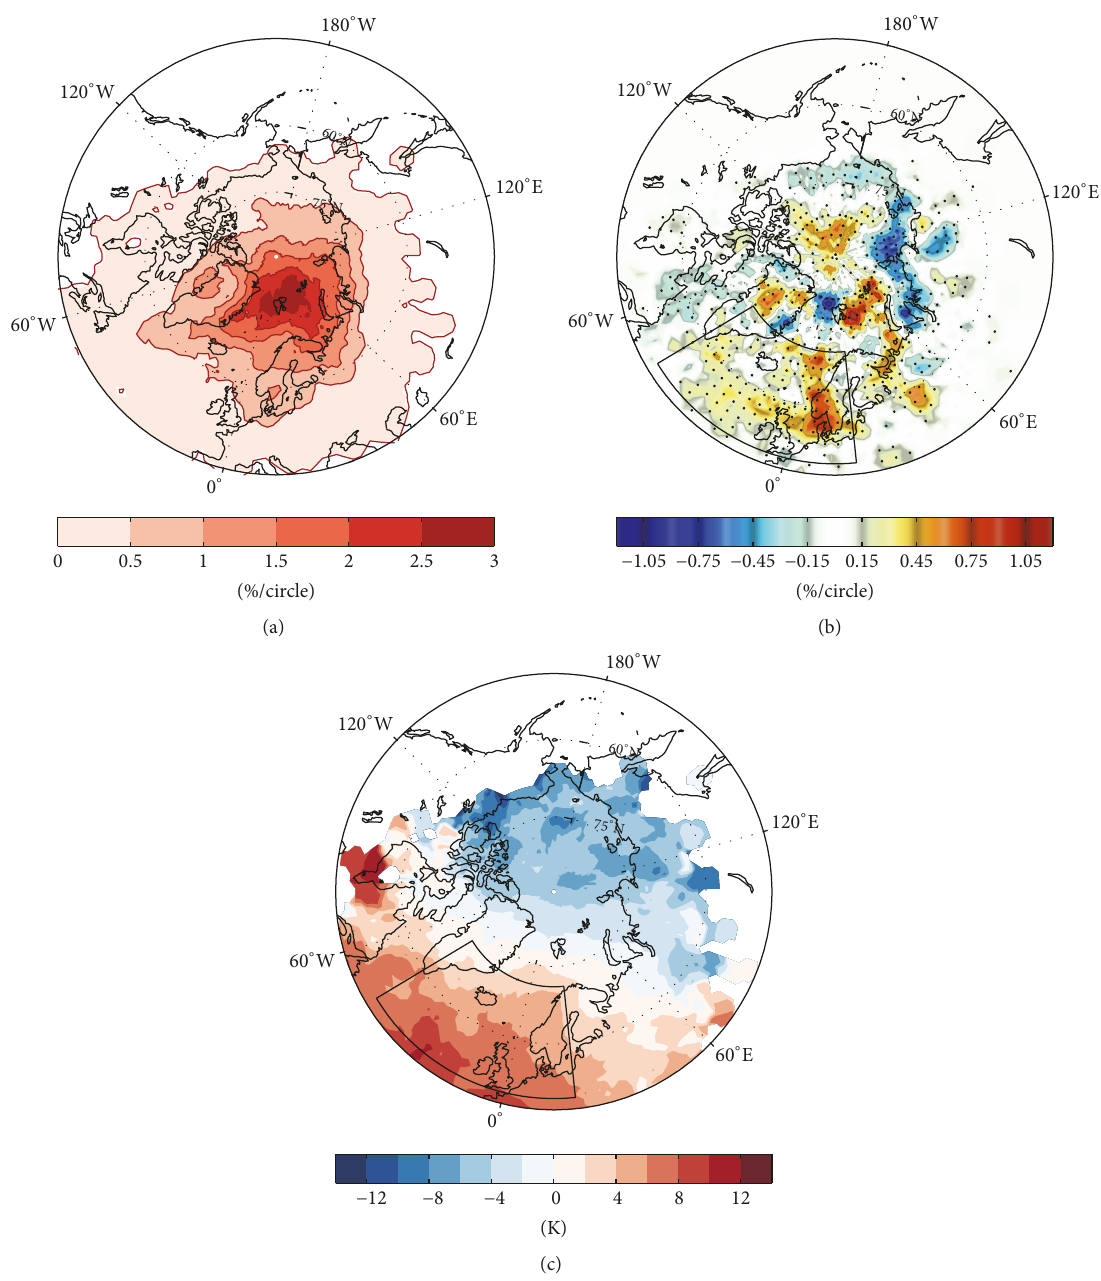
Figure 3: (a) Probability distribution map for DJF source regions of Ny-˚Alesund air at 1500m height. (b) Change in probability expressed as difference P2 (Dec. 2006–Feb. 2016) minus P1 (Dec. 1996–Feb. 2006). Statistical significance (99%) is indicated by dots and only shown for changes exceeding ± 0.1%/circle (see text for details). (c) Ny-˚Alesund temperature anomaly as a function of source region. The ATL box (see Section 3.1) is drawn in panels (b) and